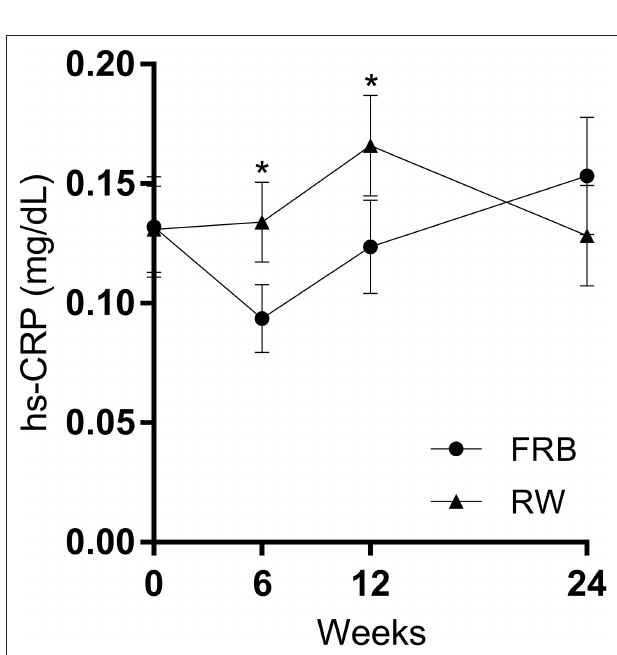
FIGURE 4 | Serum high-sensitive C-reactive protein (hs-CRP) at base-line, after 6 and 12 weeks of intervention and 12 weeks post intervention (week 24) in the fermented rye bran (FRB) and in the refined wheat (RW) group among all completed cases. Observations ≥ 1 mg/dL were removed ( n = 6 in FRB and n = 5 in RW, 1.9% of all observations). Data is mean ± SEM. Statistically significant differences are indicated by * p <